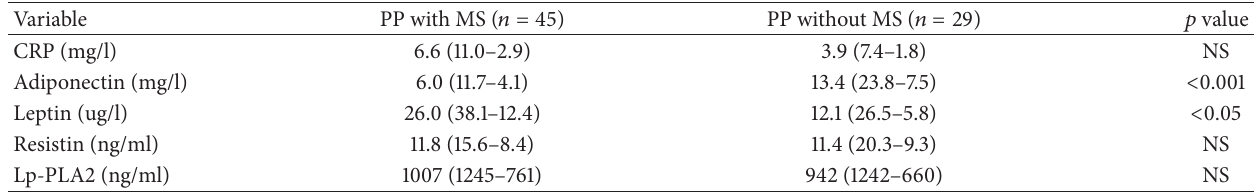
Table 5: Inflammatory markers in the patients (PP) with and without metabolic syndrome